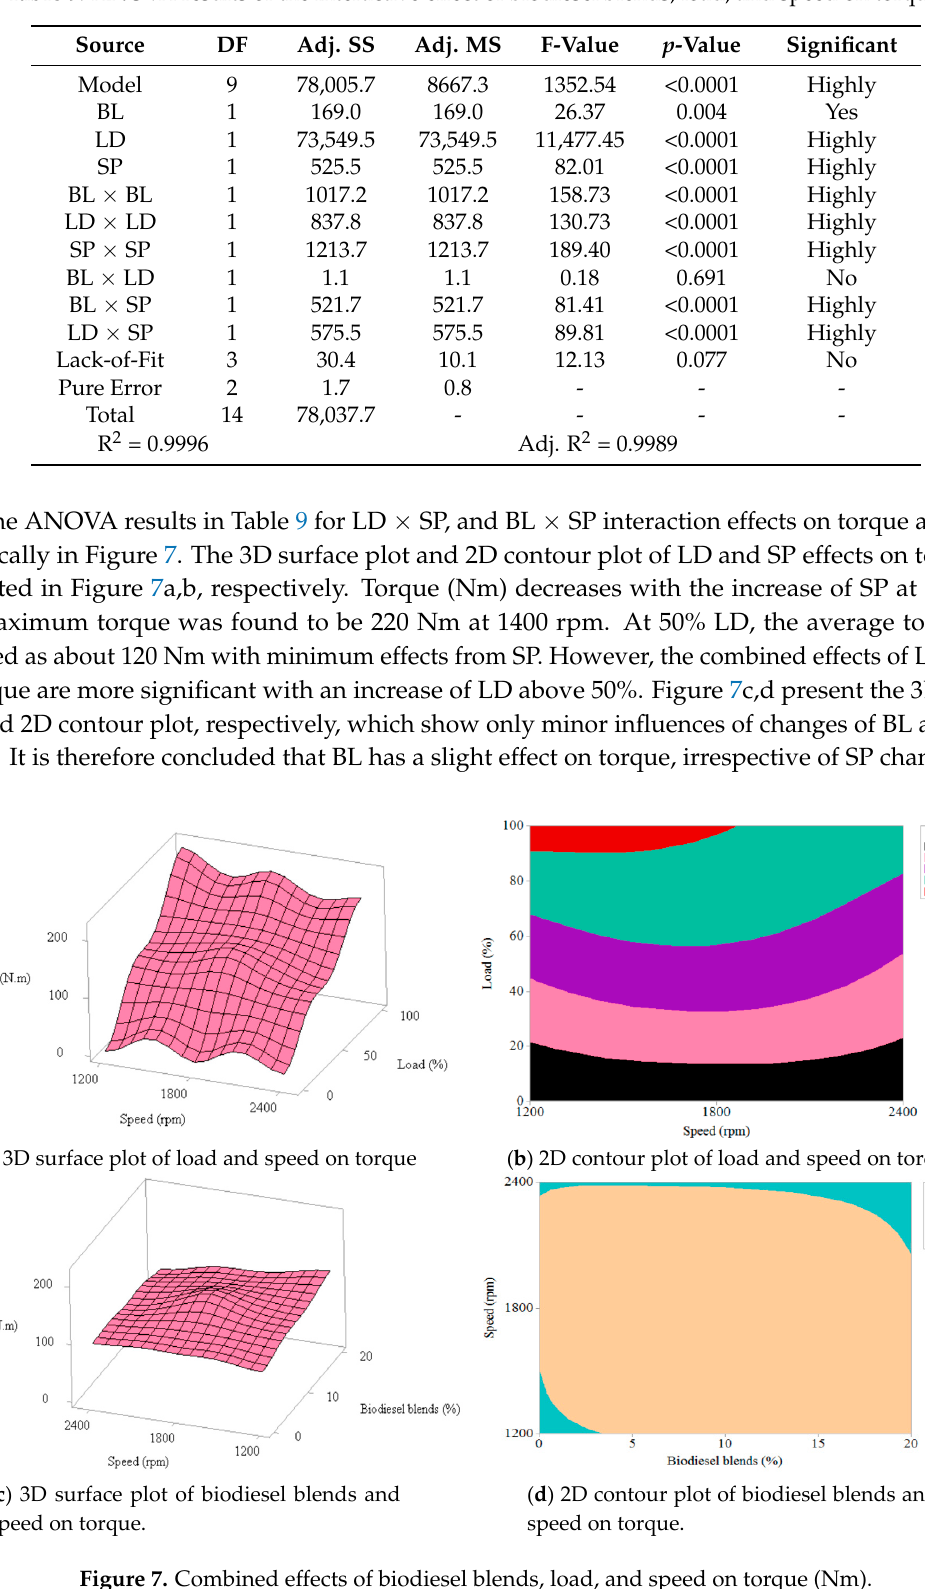
Table 9. ANOVA results of the interactive effect of biodiesel blends, load, and speed on torque.